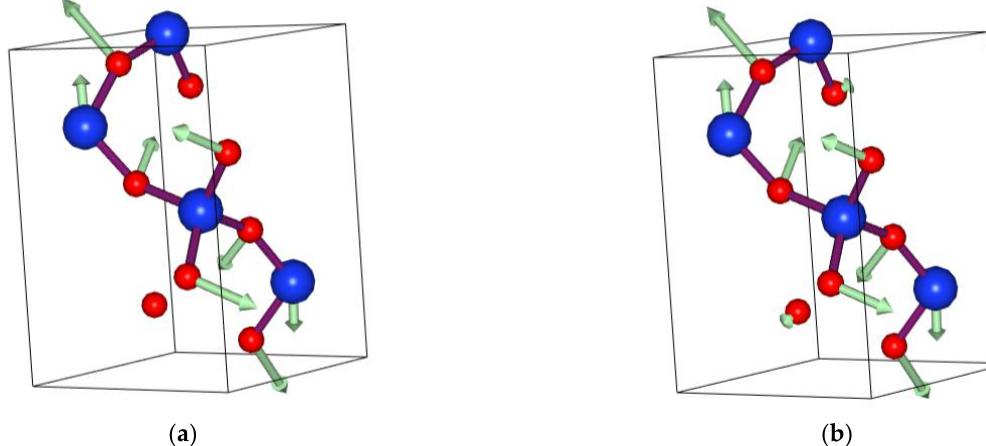
Figure 4. ( a ) Atom displacement patterns at 0 K. ( b ) Atom displacement patterns at 300 K. The vibration directions are depicted by green arrows, on an arbitrary scale for better visualization. The red balls are O atoms. The blue balls are Si atoms.